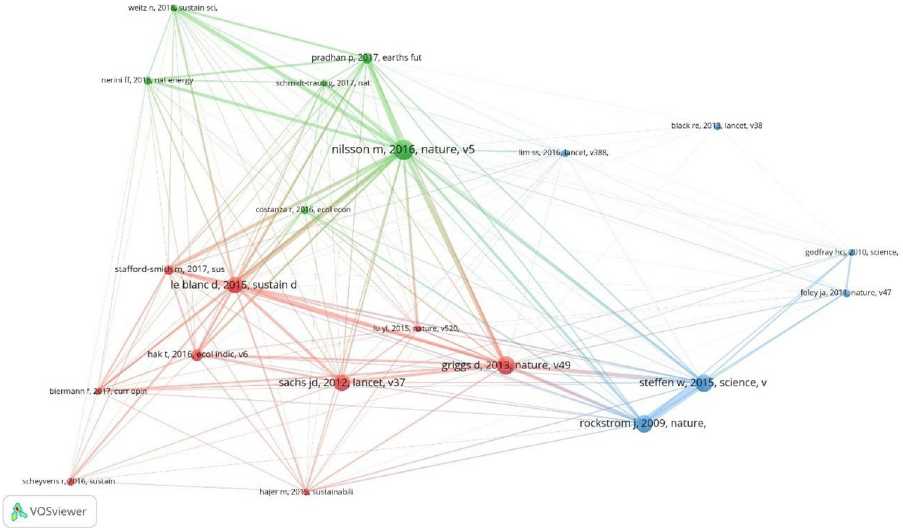
Fig 4. Cocitation graph, data source WoS.